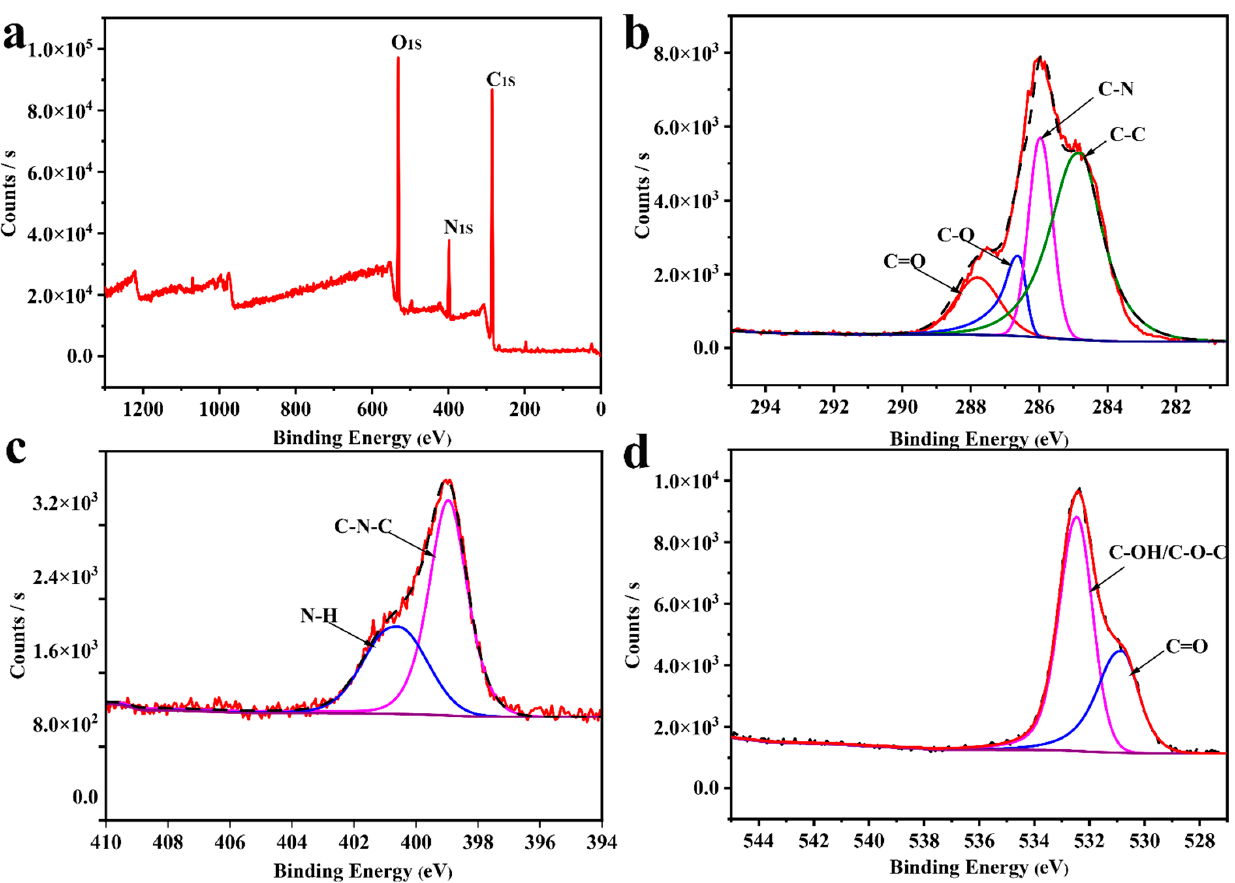
Figure 3. XPS scanning spectrum of CD C-H ( a ) and high-resolution spectrum of C 1s ( b ), N 1s ( c ), and O 1s ( d ). The red line represents the binding energy profile, and the black line represents the binding energy profile after the split-peak fitting.